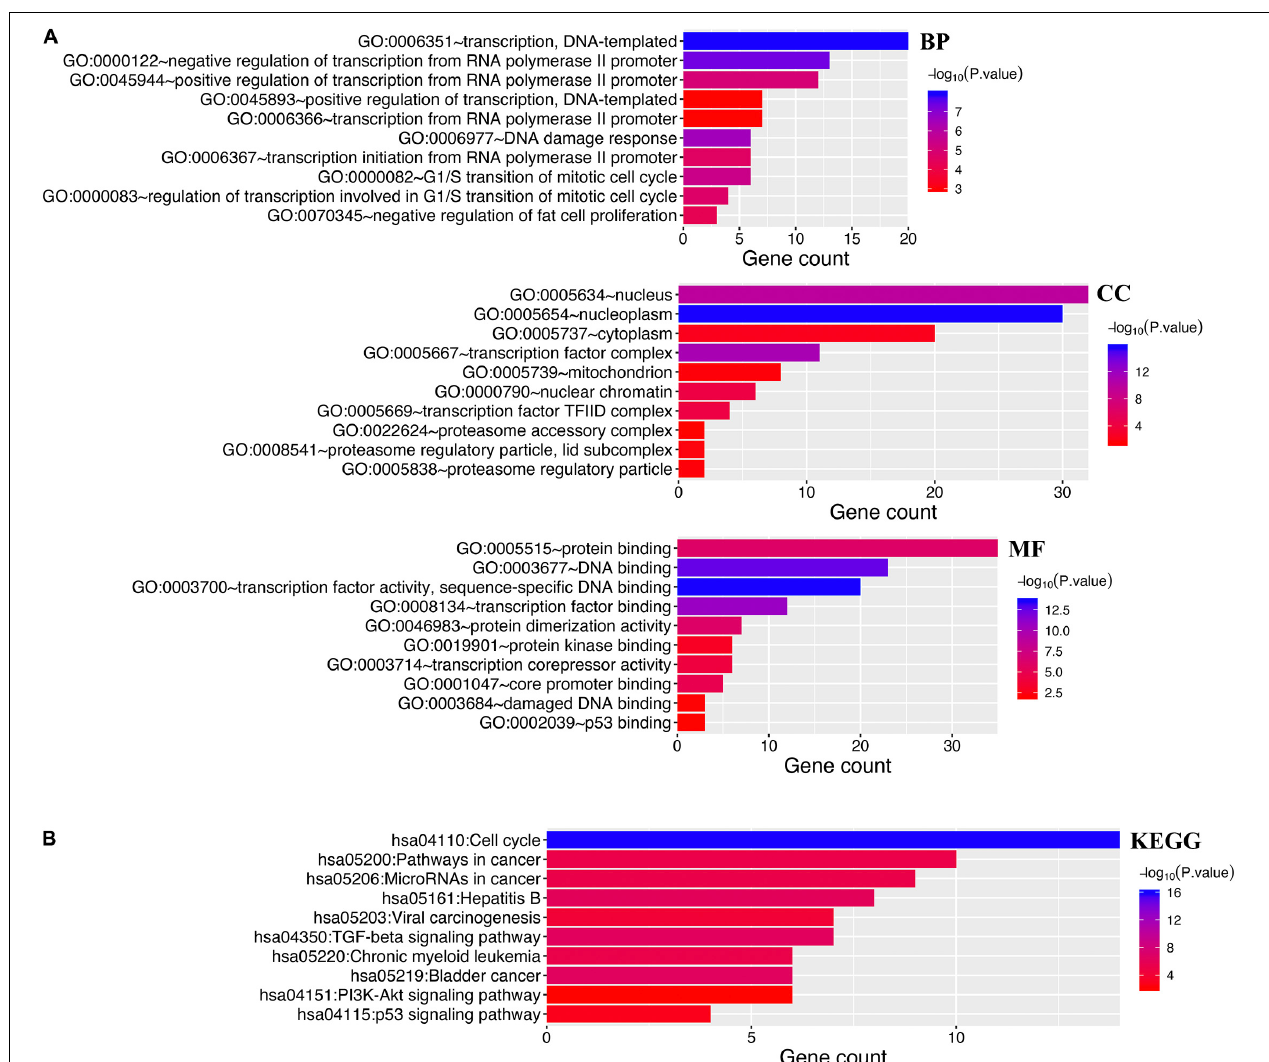
FIGURE 13 | Enrichment analysis of both E2Fs and neighboring genes in UCEC. (A) Bar graph of top 10 enriched GO pathways. (B) KEGG derived Bar graph of the significantly enriched